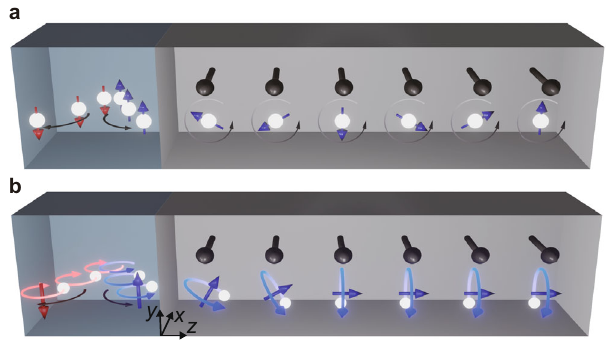
Fig. 1 Spin and orbital transport in ferromagnets. a Schematic illustration of the spin Hall effect and spin transport in a ferromagnetic/nonmagnetic bilayer. The black arrow represents the local spins in the ferromagnetic layer. The blue and red arrows denote the up and down spins, respectively. The injected spin, the blue arrow, precesses around the local spin due to the spin exchange coupling in the ferromagnetic layer. b Schematic illustration of the orbital Hall effect and orbital transport in a ferromagnetic/ nonmagnetic bilayer. The blue and red arrows, associated with the motion of the electrons, denote the orbital angular momentum. The orbital Hall effect generates the orbital current carrying the y component of the orbital angular momentum L y . The orbital angular momentum, the blue arrow, injected into the ferromagnetic layer induces z component of the orbital angular momentum, L z , through a combined action of the spin-orbit coupling and spin exchange coupling. The induced L z fl ows without oscillation through the hot-spots in the momentum space in the ferromagnetic